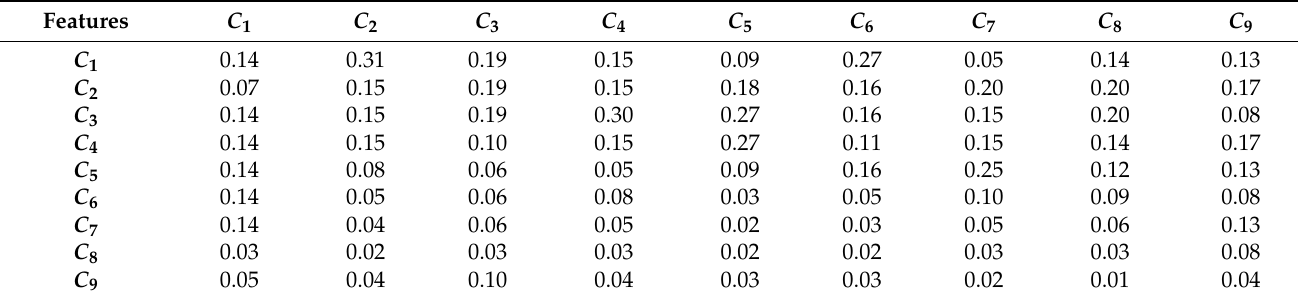
Table 2. Normalized pairwise